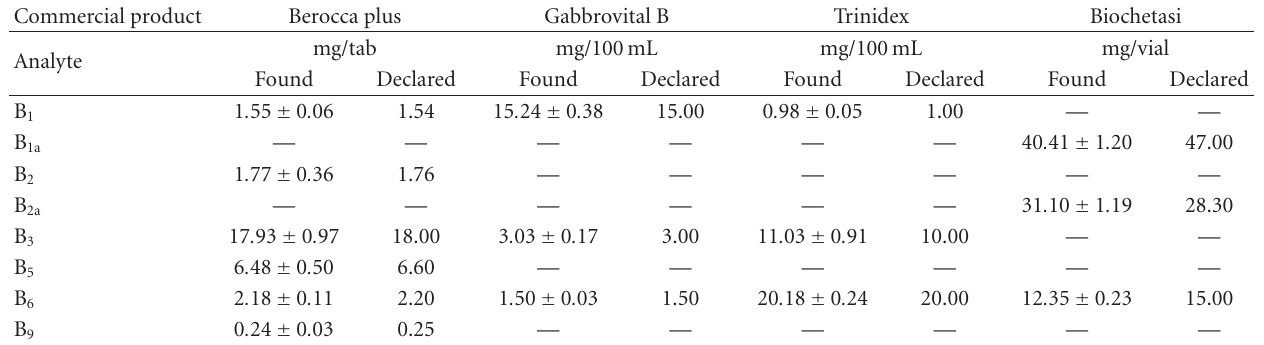
Table 3: Commercial product